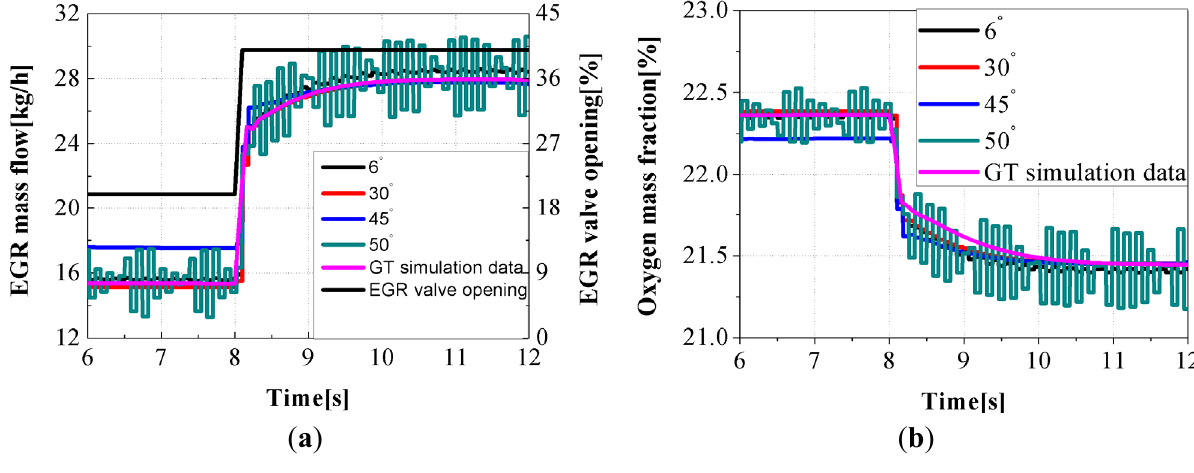
Figure 8. Oxygen mass fraction estimation. ( a ) EGR mass flow and EGR valve opening; ( b ) Oxygen mass fraction.